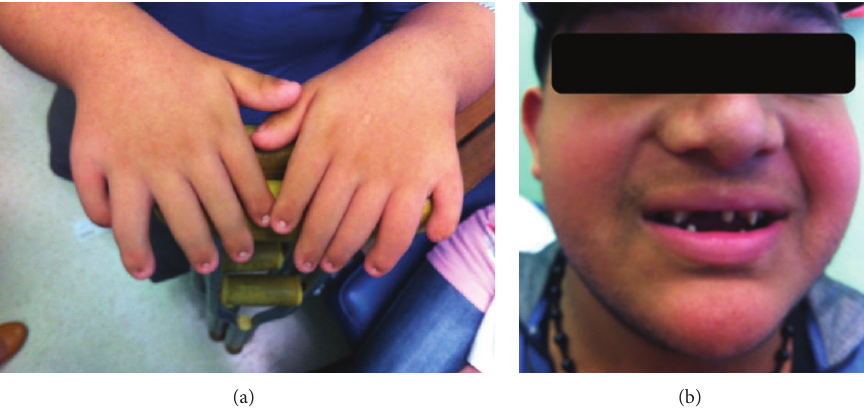
Figure 4: Clinical photos of patient from Family 2 showing conical shaped teeth and